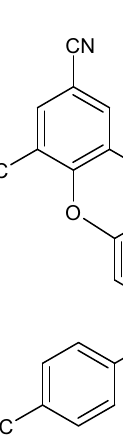
Figure 20. The novel potential agents with anti-HIV activity bearing a phenoxy group.